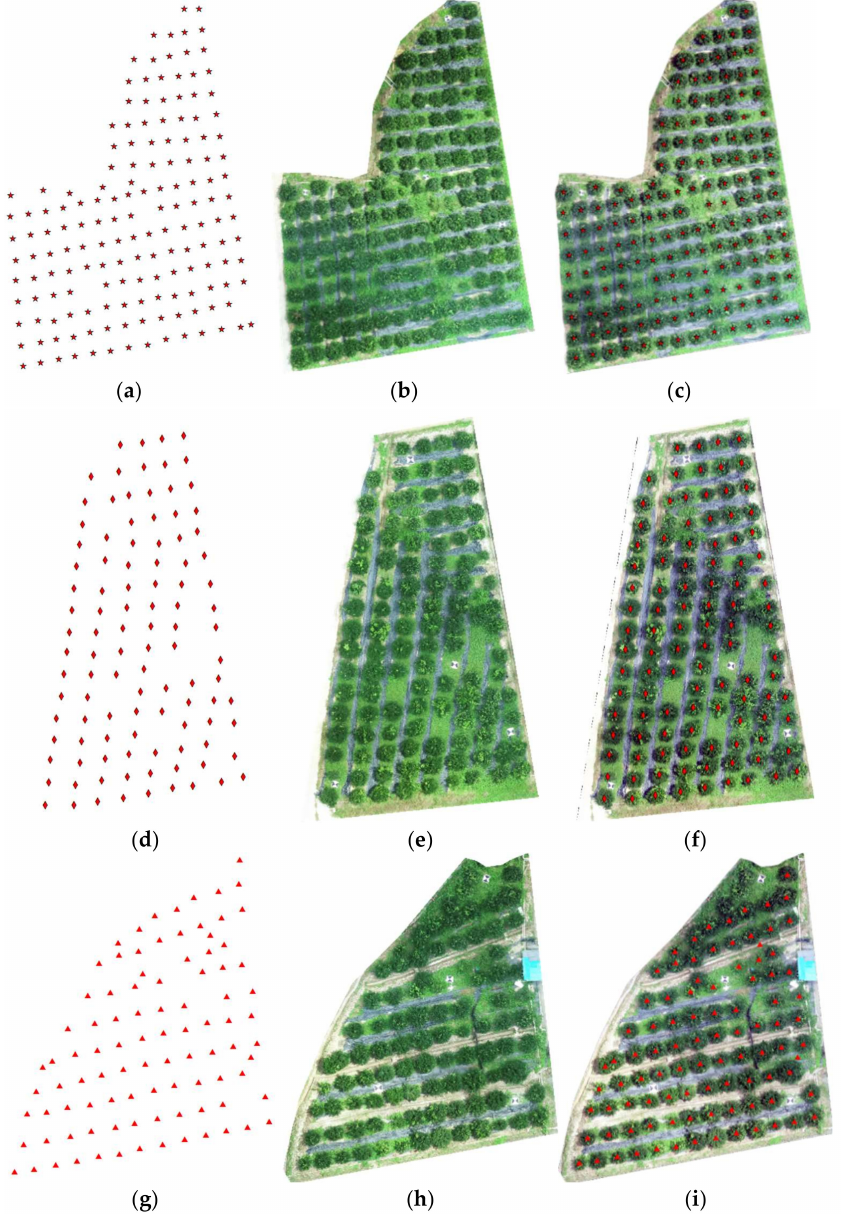
Figure 12. UTM coordinate verification. ( a – c ) are experimental plot 1; ( d – f ) are experimental plot 2; ( g – i ) are experimental plot 3; ( a , d , g ) are converted UTM projection coordinate points; ( b , e , h )